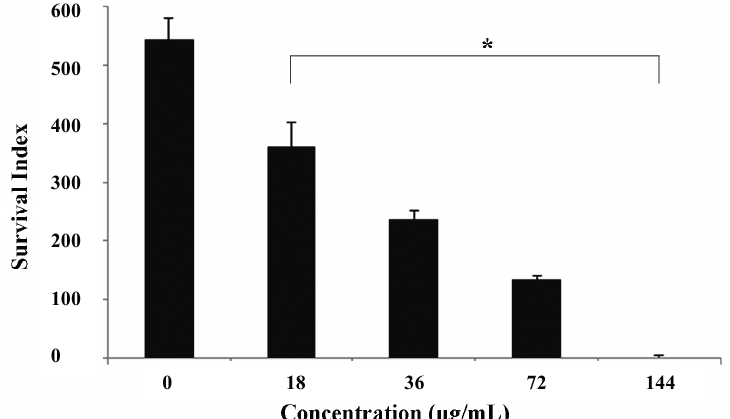
Figure 2. Survival index of Leishmania amazonensis within macrophages after 18 h of treatment with the